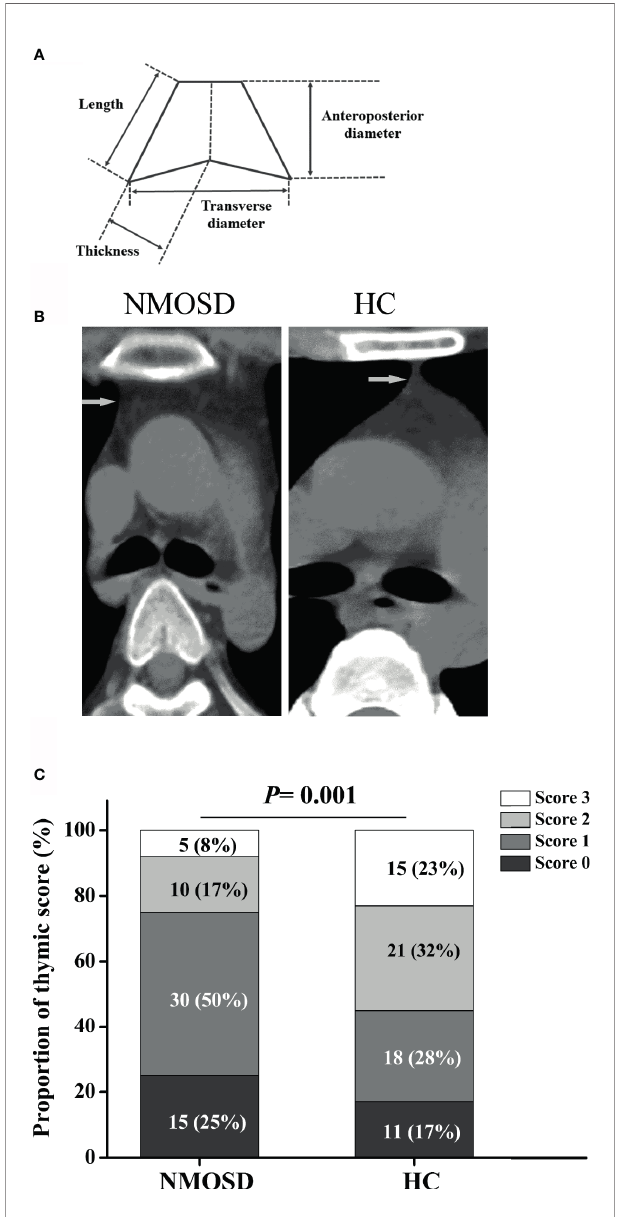
FIGURE 4 | Schematic illustration of thymus measurements and the proportion of thymic scoring. (A) Schematic illustration of thymus measurement; (B) Representative axial CT images of thymus in age- and sex- matched NMOSD and HC groups (two 32-year-old women). (C) The proportion of thymic scoring, Score 0, complete fatty replacement and no identi fi able soft tissue density in the thymic bed; Score 1, predominantly fatty thymus; Score 2, approximately one-half fatty and one half soft-tissue attenuated thymus; Score 3, predominantly soft-tissue attenuated thymus. NMOSD, Neuromyelitis optica spectrum disorder; HC, healthy controls.